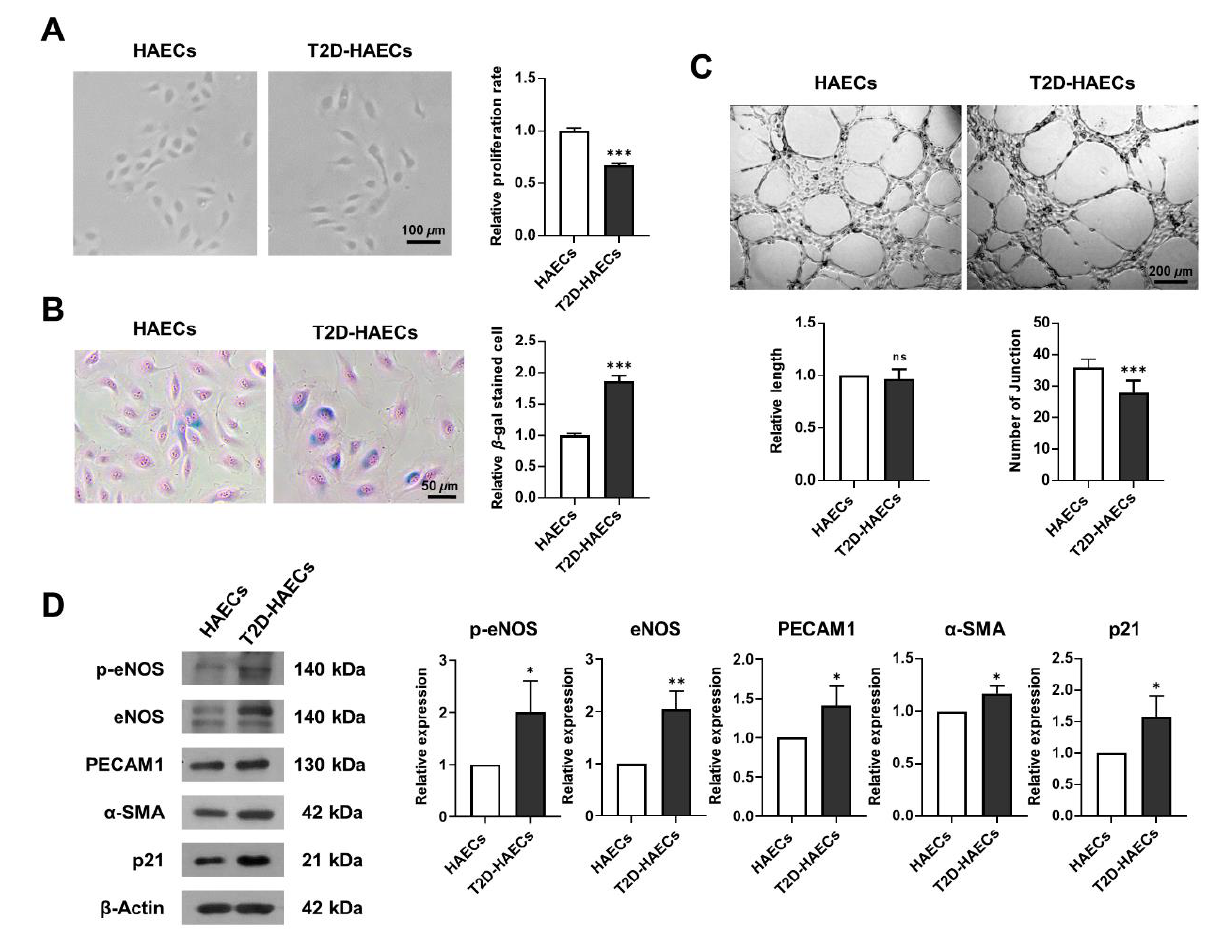
Figure 1. Characterization of functions of primary human aortic endothelial cells (HAECs) and human aortic endothelial cells, diabetes type II (T2D-HAECs). ( A ) Representative images of cultured HAECs and T2D-HAECs. The proliferative rates of HAECs and T2D-HAECs were measured using an MTT assay (n = 4). ( B ) β -galactose staining and quantification in HAECs and T2D-HAECs. Blue represents β -galactose-positive staining (n = 3). ( C ) Images of tube formation in HAECs and T2D- HAECs 16 h after seeding of 1.5 × 10 4 cells/100 µ L. The length and number of tube junctions were counted and compared in each group (n = 6). ( D ) Western blotting of endothelial cell function- related proteins (n = 3). Quantification of each protein is shown in the graph. All data represent the mean ± standard deviation (SD) of each independent experiment; * p < 0.05; ** p < 0.01; *** p < 0.005; ns = no significance.